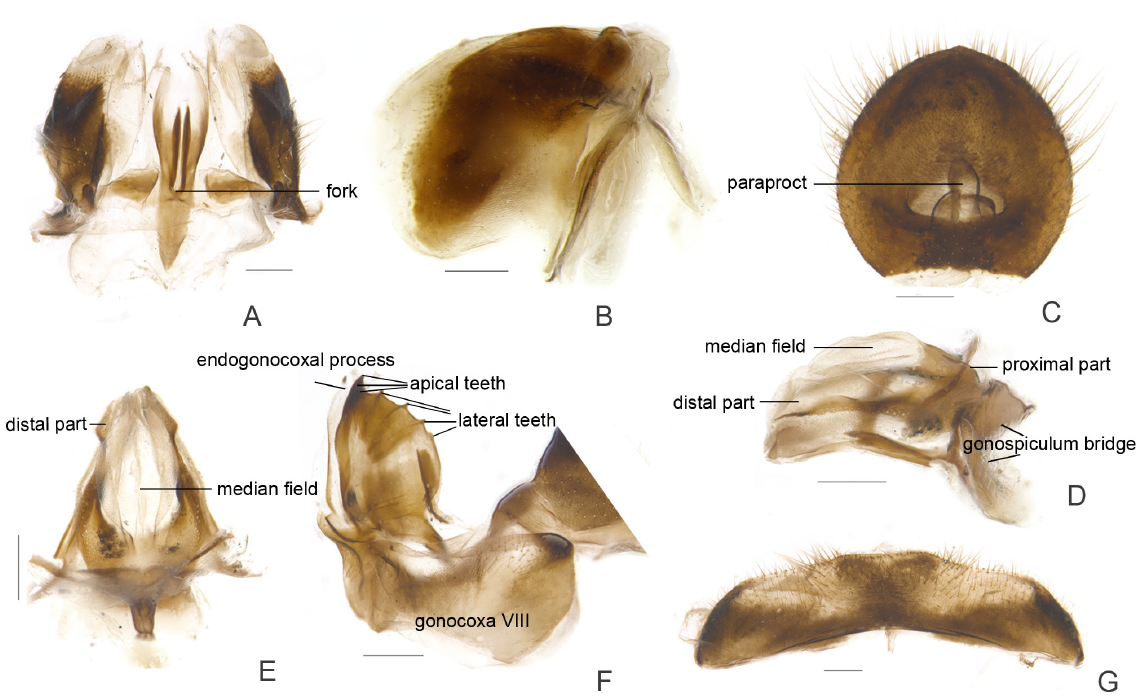
Fig. 4. Gergithus frontilongus sp. nov. A . Gonoplac, dorsal view. B . Gonoplac, right view. C . Female anal tube, dorsal view. D . Gonapophysis IX and gonaspiculum bridge, right view. E . Gonapophysis IX and gonaspiculum bridge, dorsal view. F . Gonocoxa VIII and gonapophysis VIII, right view. G . Sternum VII, ventral view. Scale bars =